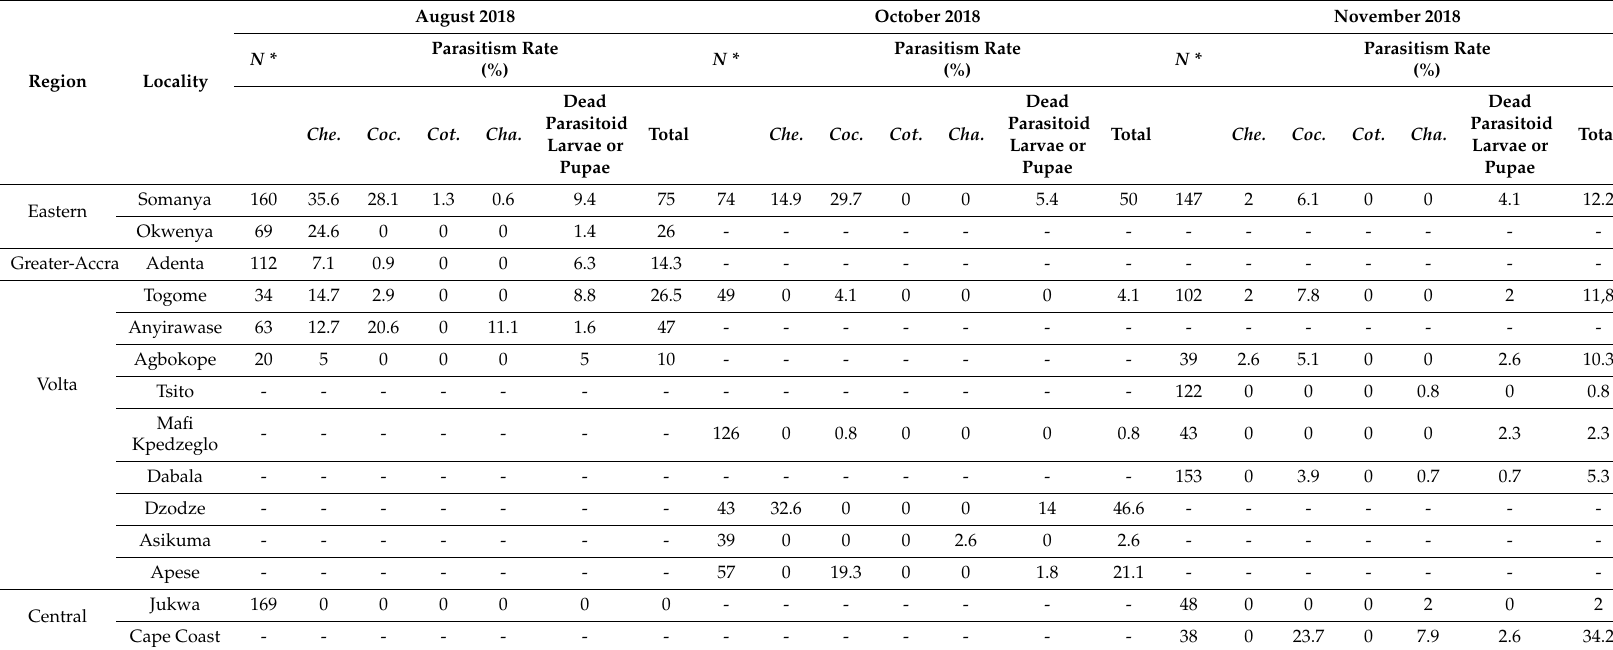
Table 5. Percentage of parasitism by egg–larval and larval parasitoids of Spodoptera frugiperda in selected localities in Ghana from August to November 2018. The mortality rate of the collected S. frugiperda larvae that died without producing a parasitoid ranged between 2.3% and 17.6%, 5.3% and 13.6% and 0% and 9.3% in August, October and November 2018,